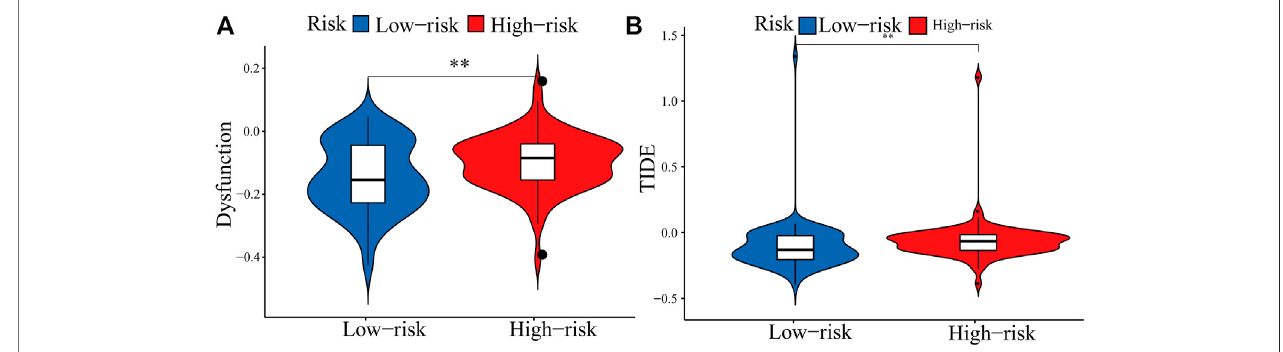
FIGURE 9 | Boxplots showed the scores of immune in fi ltrations and functions among the PRM. (A) Dysfunction. (B) TIDE.